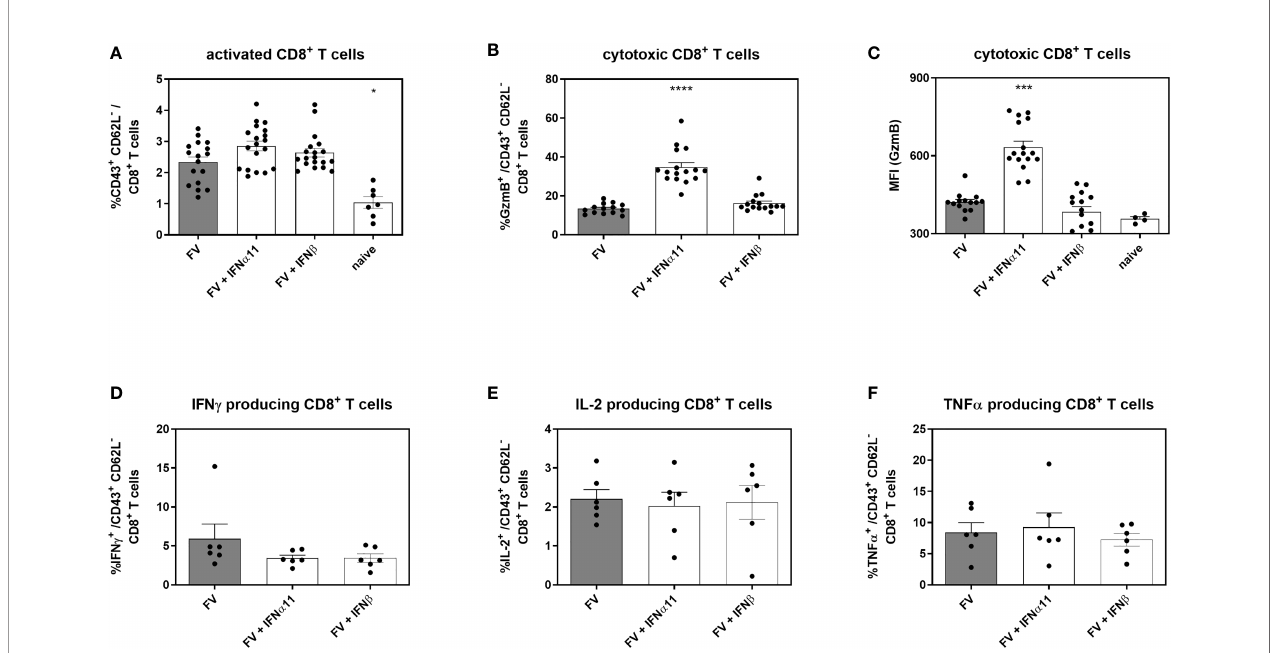
FIGURE 5 | Analysis of intracellular cytotoxic molecules and cytokine expression of CD8 + T cells in type I IFN-treated chronically FV-infected mice. C57BL/6 mice were infected with 20,000 SFFU of FV and additional 100,000 FFU of F-MuLV. Mice were treated daily with 8000 units of IFN a 11 or IFN b from day 40 to 44 mice. At day 45 post infection, mice were sacri fi ced and CD8 + T cell effector functions were analyzed by fl ow cytometry. Percentages of CD43 + CD62L - activated CD8 + T cells (A) and percentages of intracellular GzmB expression (B) and individual GzmB expression (MFI) was determined (C) . Multi-parametric fl ow cytometry was used to measure percentages of intracellular expression of IFN g (D) , IL-2 (E) and TNF a (F) in activated CD8 + T cells. Mean values (+SEM) are indicated by bars. Statistically signi fi cant differences between the IFN-treated groups and the untreated group were analyzed using Kruskal-Wallis one-way analysis and Dunn ’ s multiple comparison and are indicated by * for p < 0.05; *** for p < 0.001; **** for p <